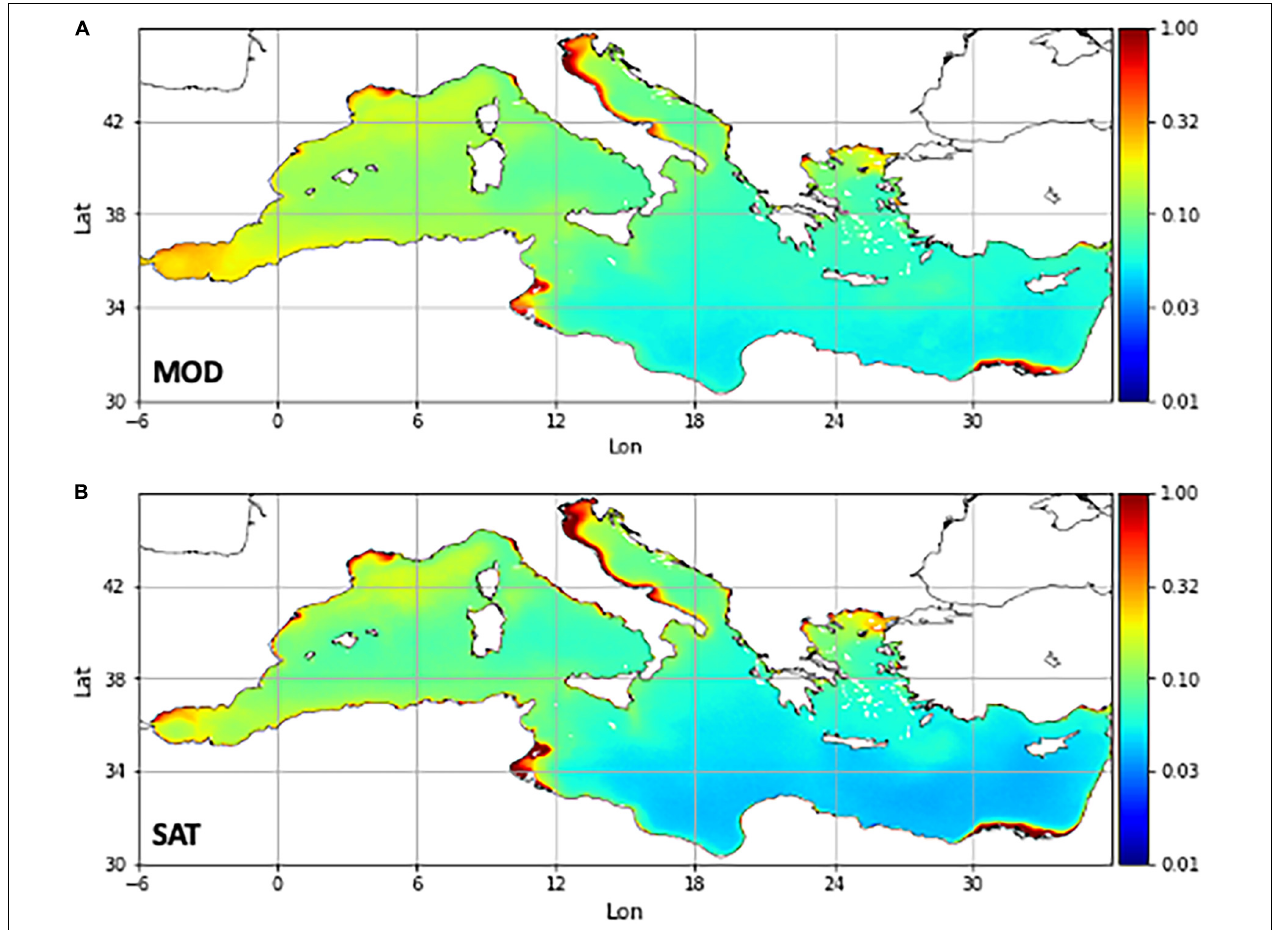
FIGURE 2 | Averaged annual maps of surface chlorophyll (in log-scale) from reanalysis (A) and from the CMEMS-OC multi-sensor satellite data (B) . The average is computed considering the period 1999–2019 over the layer 0–10 m for the reanalysis